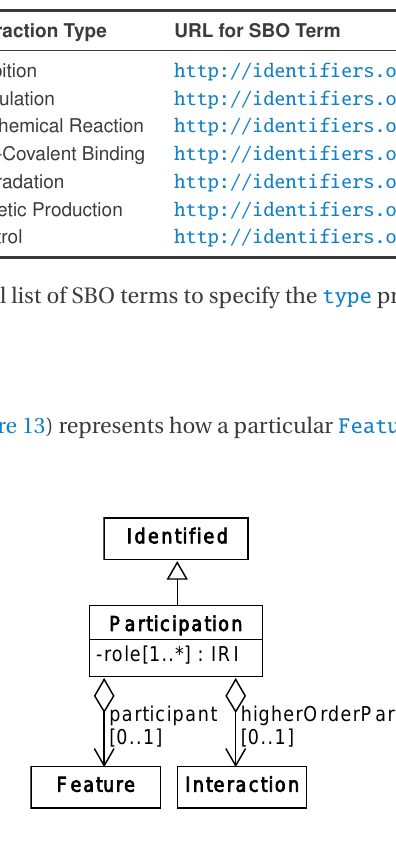
Figure 13: Diagram of the Participation class and its associated